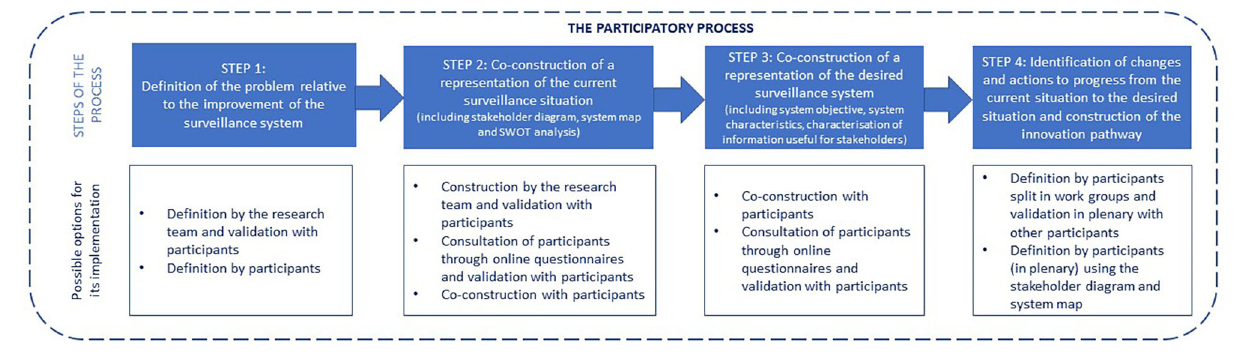
FIGURE 1 | The socio-technical framework structure and its application modalities.